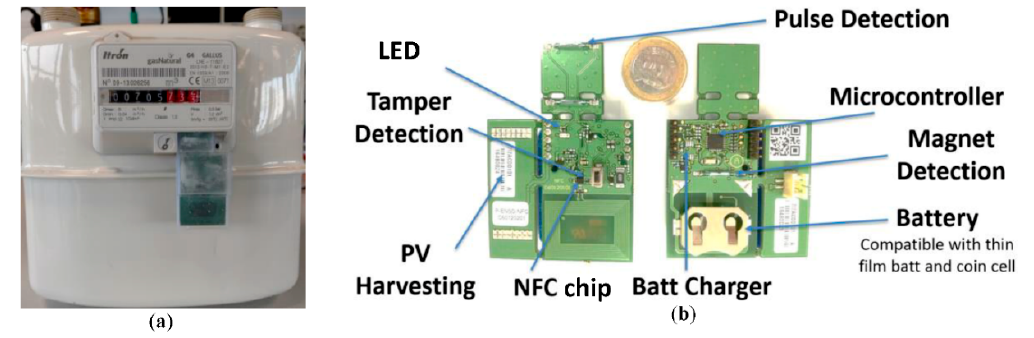
Figure 2. ( a ) Tests carried out in a simulated environment, on an ITRON counter (Gallus 2000) [6]; ( b ) PCB of the node with a description of its elements.